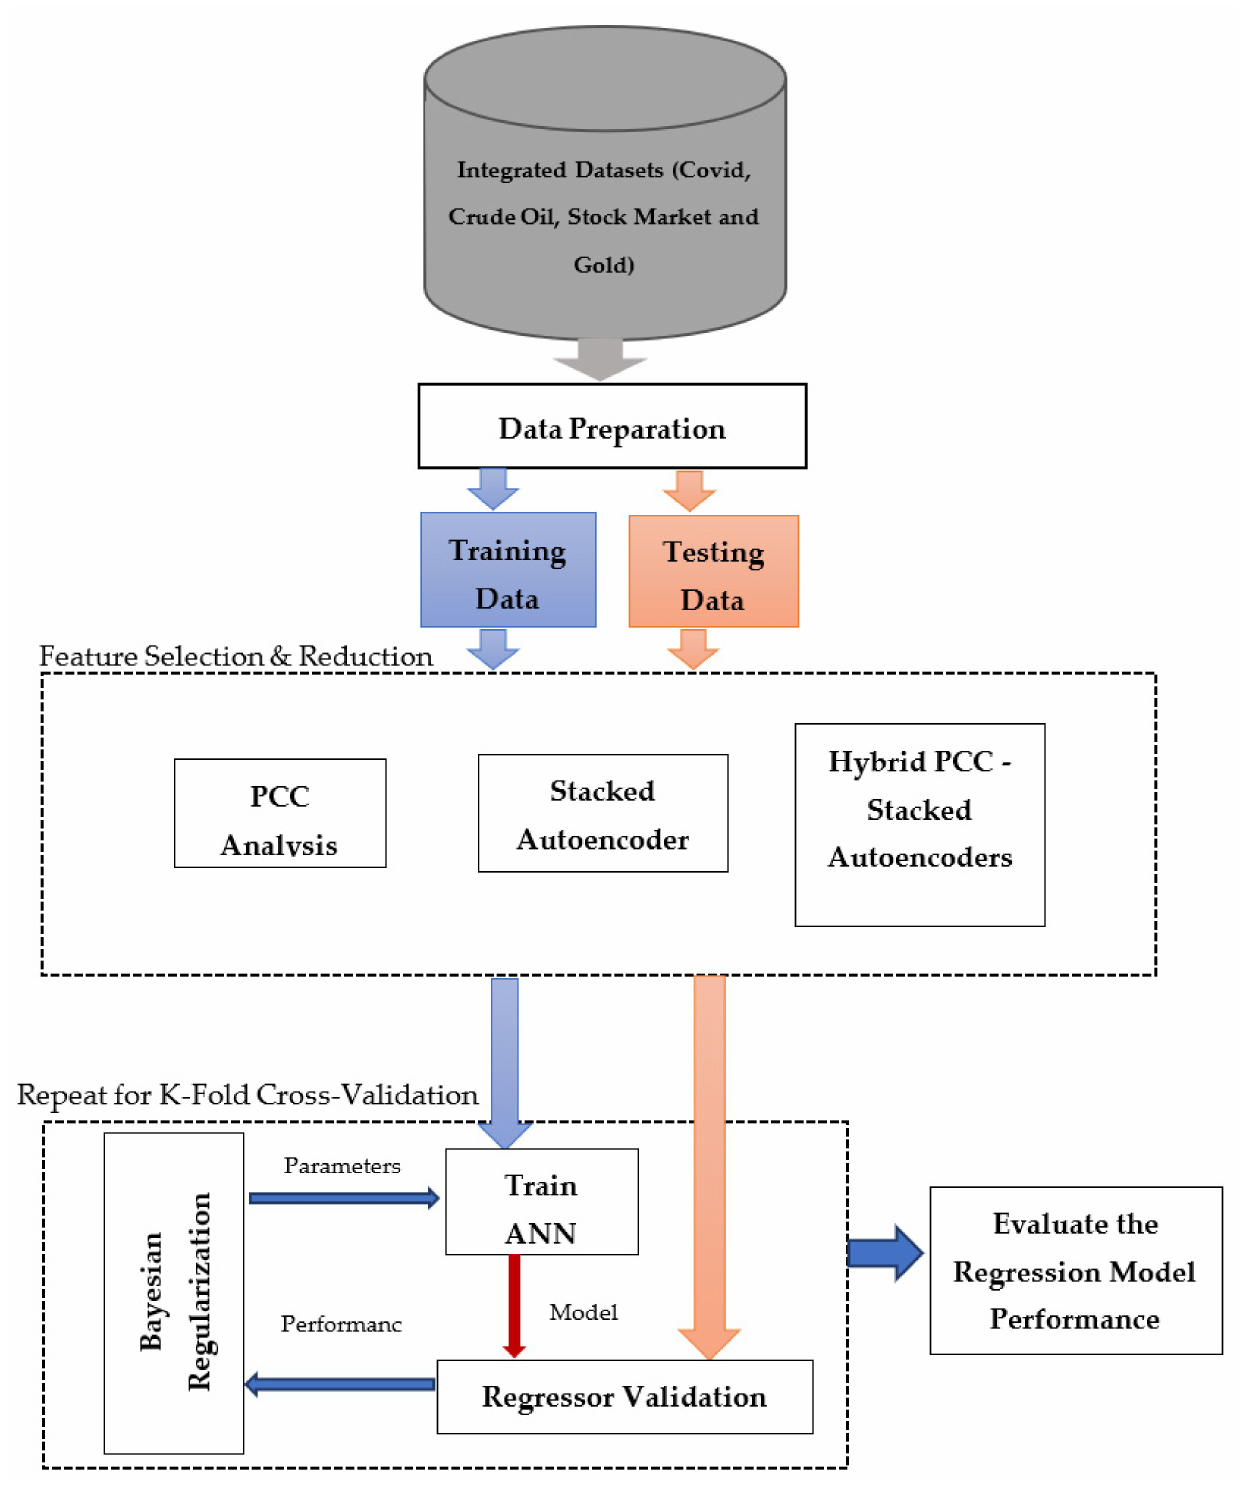
Figure 1. The framework of the proposed forecasting system for Gold, and Crude Oil